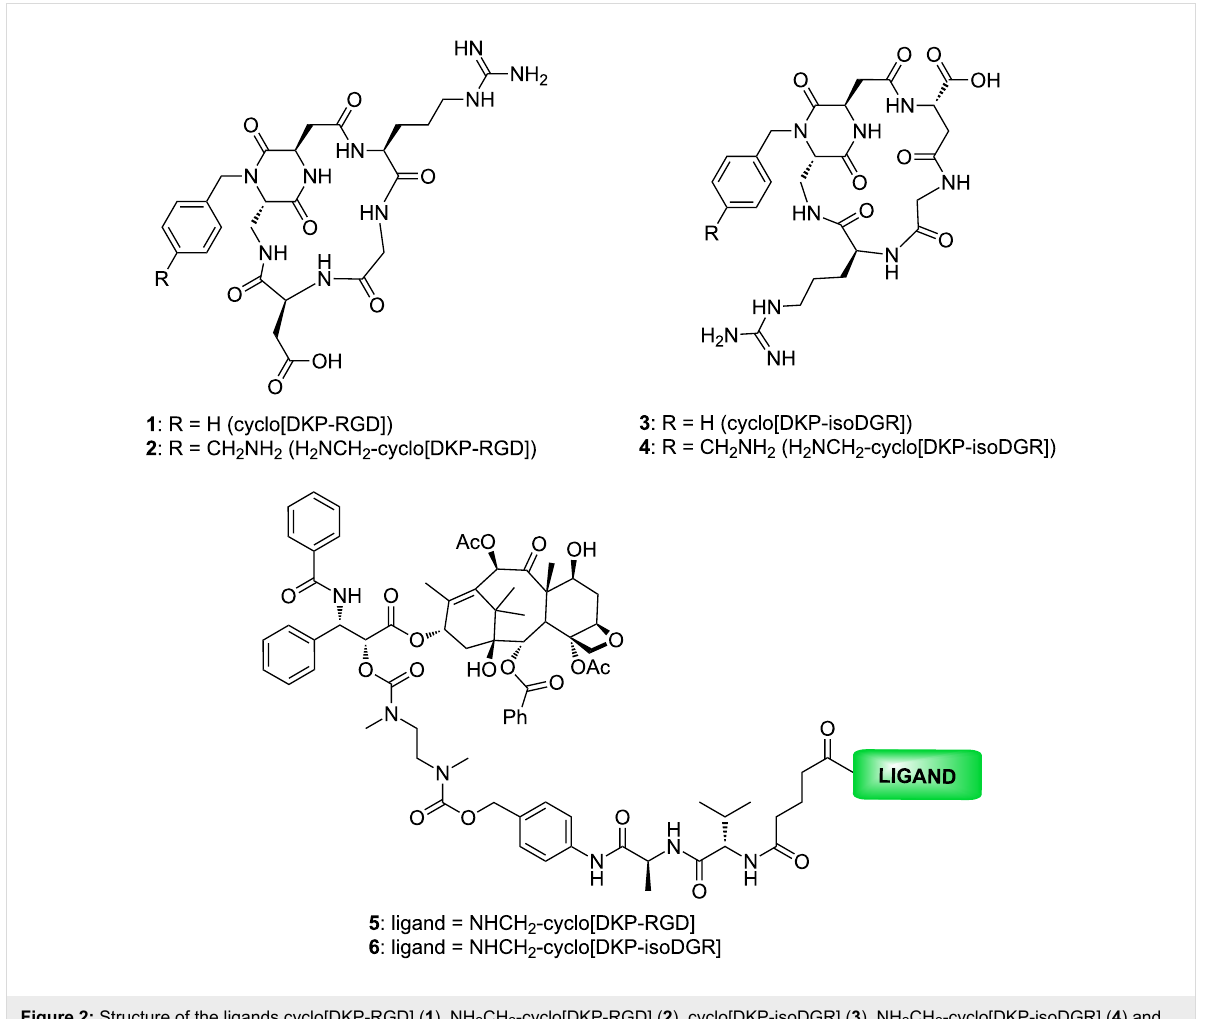
Figure 2: Structure of the ligands cyclo[DKP-RGD] ( 1 ), NH 2 CH 2 -cyclo[DKP-RGD] ( 2 ), cyclo[DKP-isoDGR] ( 3 ), NH 2 CH 2 -cyclo[DKP-isoDGR] ( 4 ) and the related SMDCs cyclo[DKP-RGD]-Val-Ala-PTX ( 5 ) and cyclo[DKP-isoDGR]-Val-Ala-PTX ( 6 ).